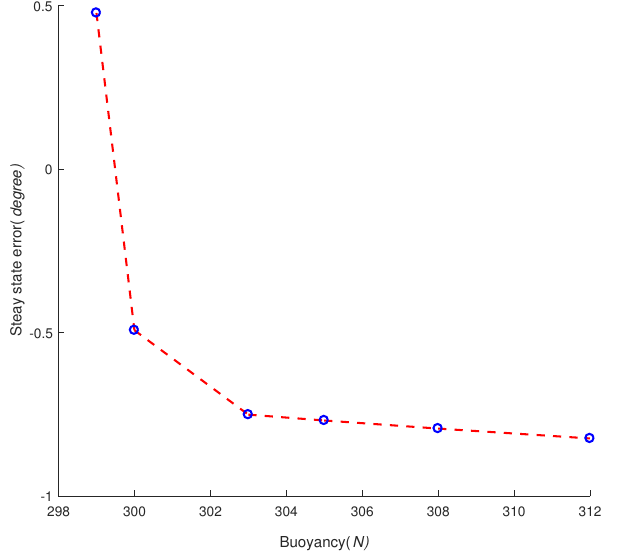
Figure 4. Relationship between the buoyancy and the steady-state